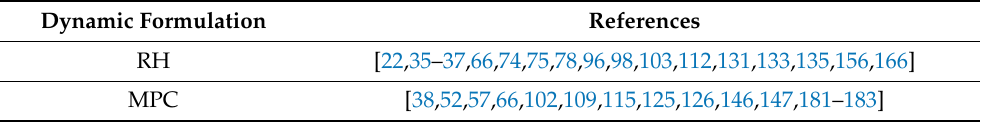
Table 5. Classification of dynamic programming mathematical formulations. Dynamic